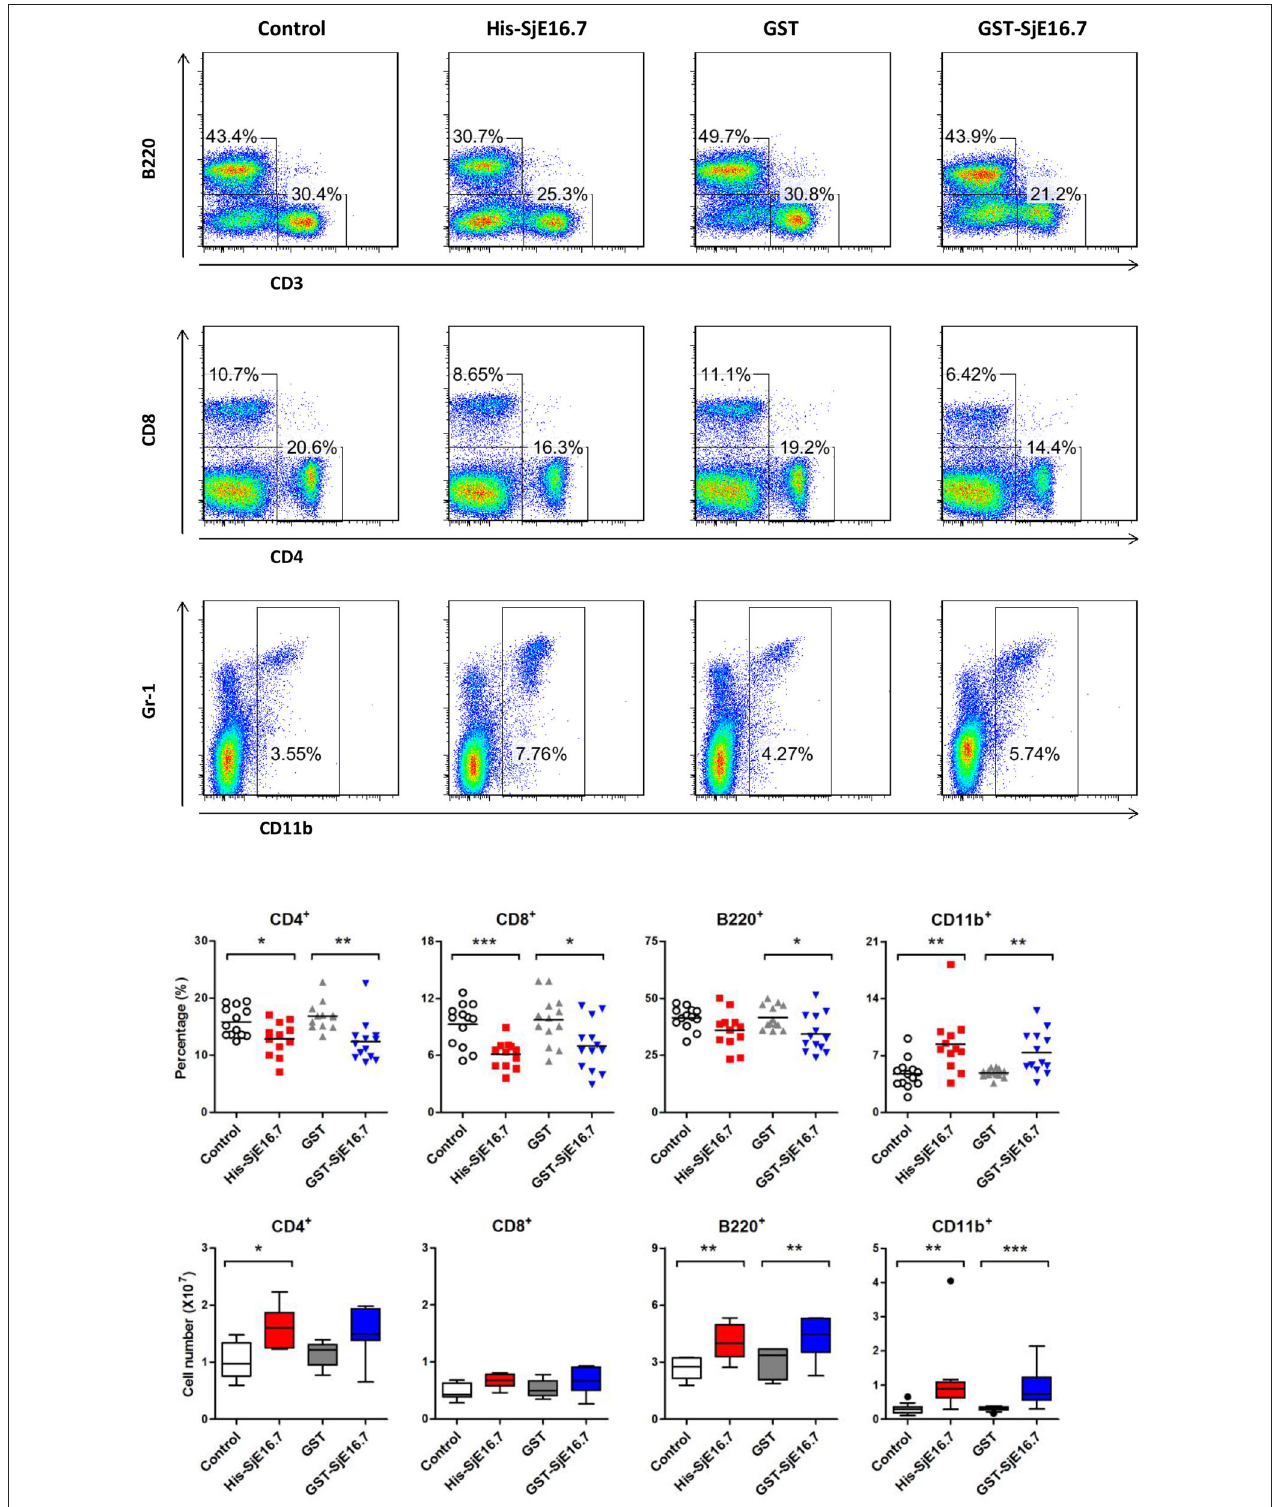
FIGURE 6 | SjE16.7 administration increases the frequency of myeloid cells in the spleen of the CAC mouse model. Splenocytes were isolated from His-SjE16.7, GST-SjE16.7, GST-control, or PBS control-treated mice 14 weeks post-CAC induction. Frequencies of splenic B220 + , CD3 + , CD4 + , CD8 + , and CD11b + cells were determined by flow cytometry. The frequency and number of cells in spleen is presented as the mean ± SEM of 12–13 individual mice per group. * p < 0.05, ** p < 0.01, *** p < 0.001 compared with the indicated control group.